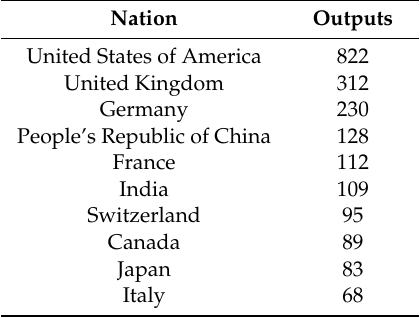
Table 2. Nations producing the largest numbers of chemoinformatics outputs.